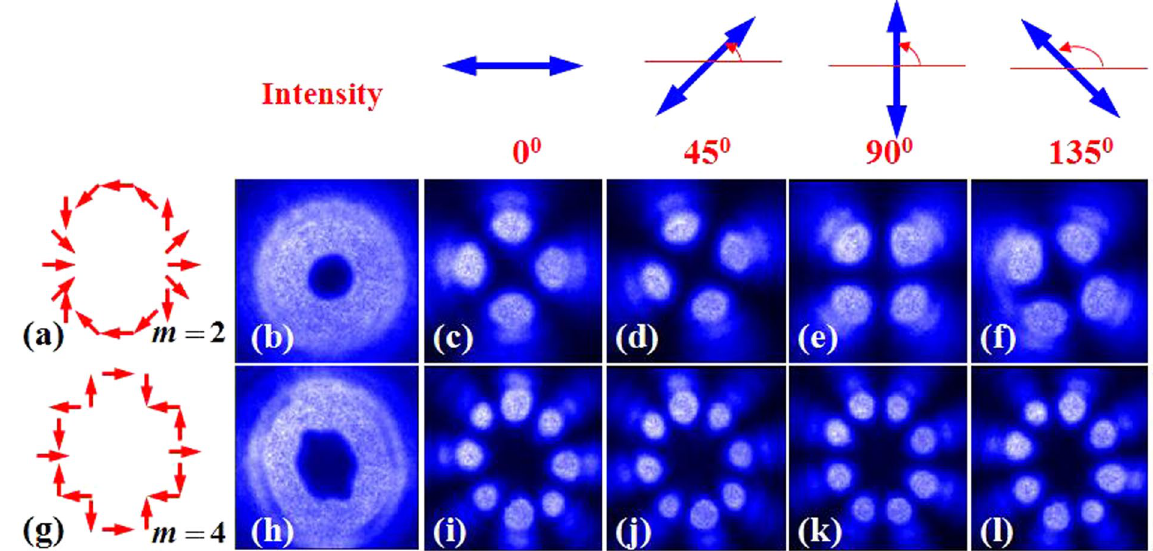
Figure 7. The intensity profiles and analyzed patterns of CVBs obtained by using metasurface. Two different polarization orders m = 2 and m = 4 are displayed from up to down. The first column shows the schematic polarization distributions (red arrow diagrams), of which the experimental results are presented in each row respectively. Different axis orientations of polarizer 0°, 45°, 90° and 135° (blue arrows in the first row) are selected in this experiment.